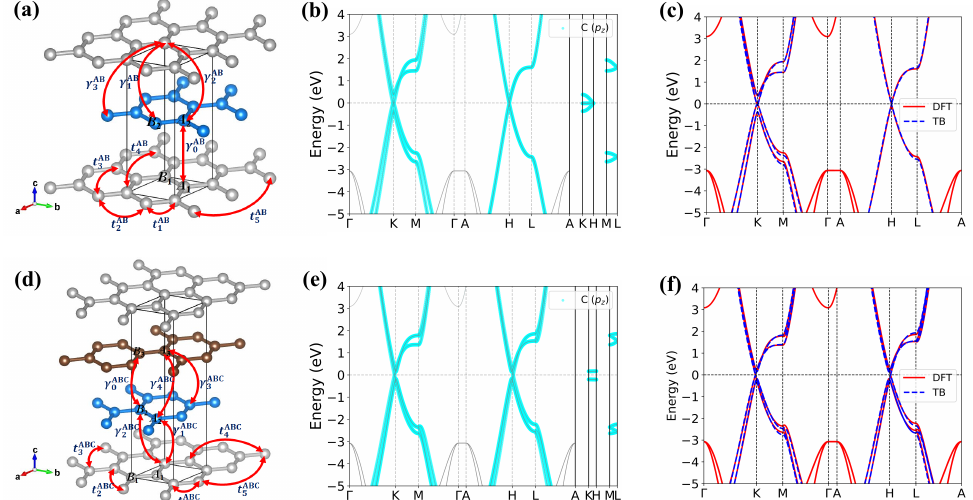
Figure A1. Lattice and electronic structure of AB and ABC graphite. ( a , d ) are the lattice structure of AB and ABC graphite, respectively. Carbon atoms in different layers are labeled in different colors (gray and blue in AB case, and gray, blue and brown in ABC case). The red arrows denote the interatomic tight-binding hopping parameters. ( b , e ) are the electronic band structure of AB and ABC graphite, respectively, with the p z orbitals of C atoms in cyan. ( c , f ) are the comparison of band structure (DFT in red line and TB in blue dashed line) for AB graphite and ABC graphite,